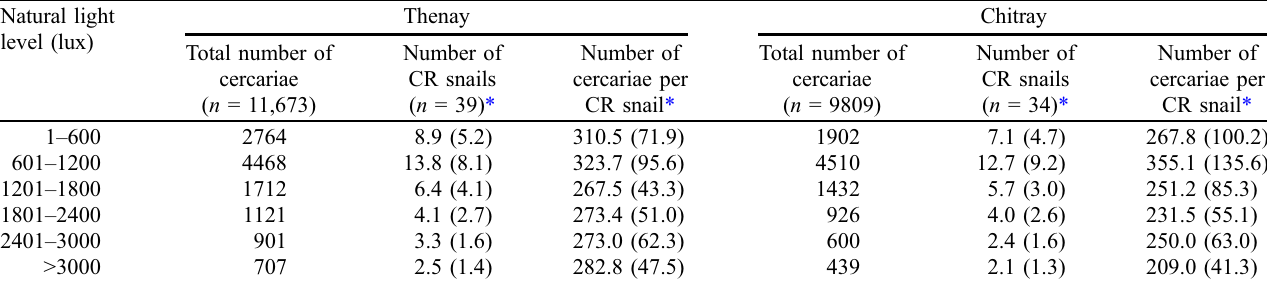
Table 3. Number of cercariae-releasing (CR) snails and number of Fasciola hepatica cercariae in the two temperature-challenged subgroups subjected to natural light during thermal shock (experiment A) in relation to light level expressed in 600-lux classes each. Natural light